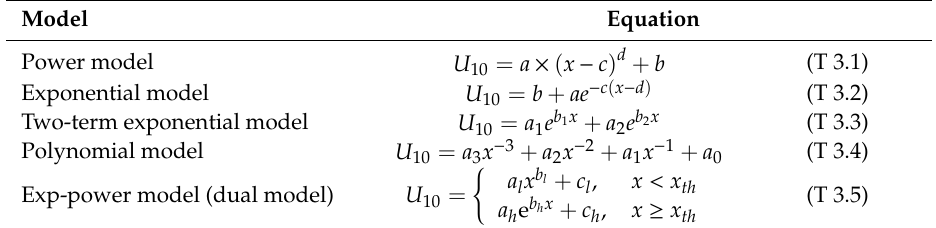
Table 3. Comparison of fitting models. (In this table, x is the observable, U 10 is the ECMWF wind speed, and the remaining symbols is the dependent parameters for each model).